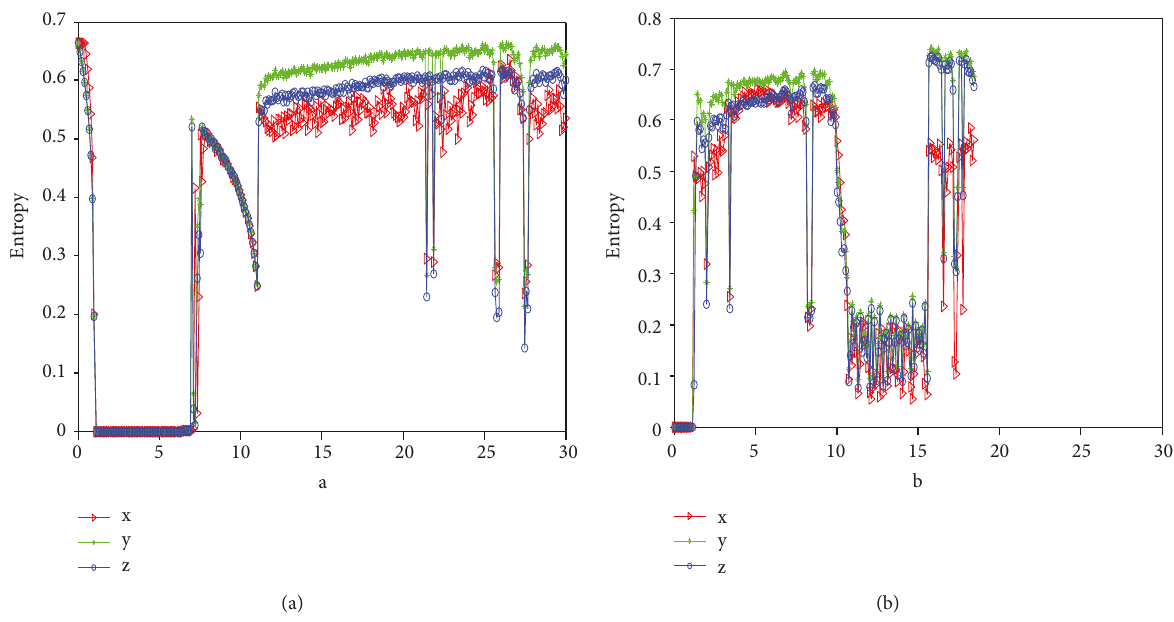
Figure 9: The spectral entropy complexity of system (2) (a) versus a ∈ 0, 30 with b , δ = 3, 0 02 ; (b) versus b ∈ 0, 30 with a , δ = 28, 0 02